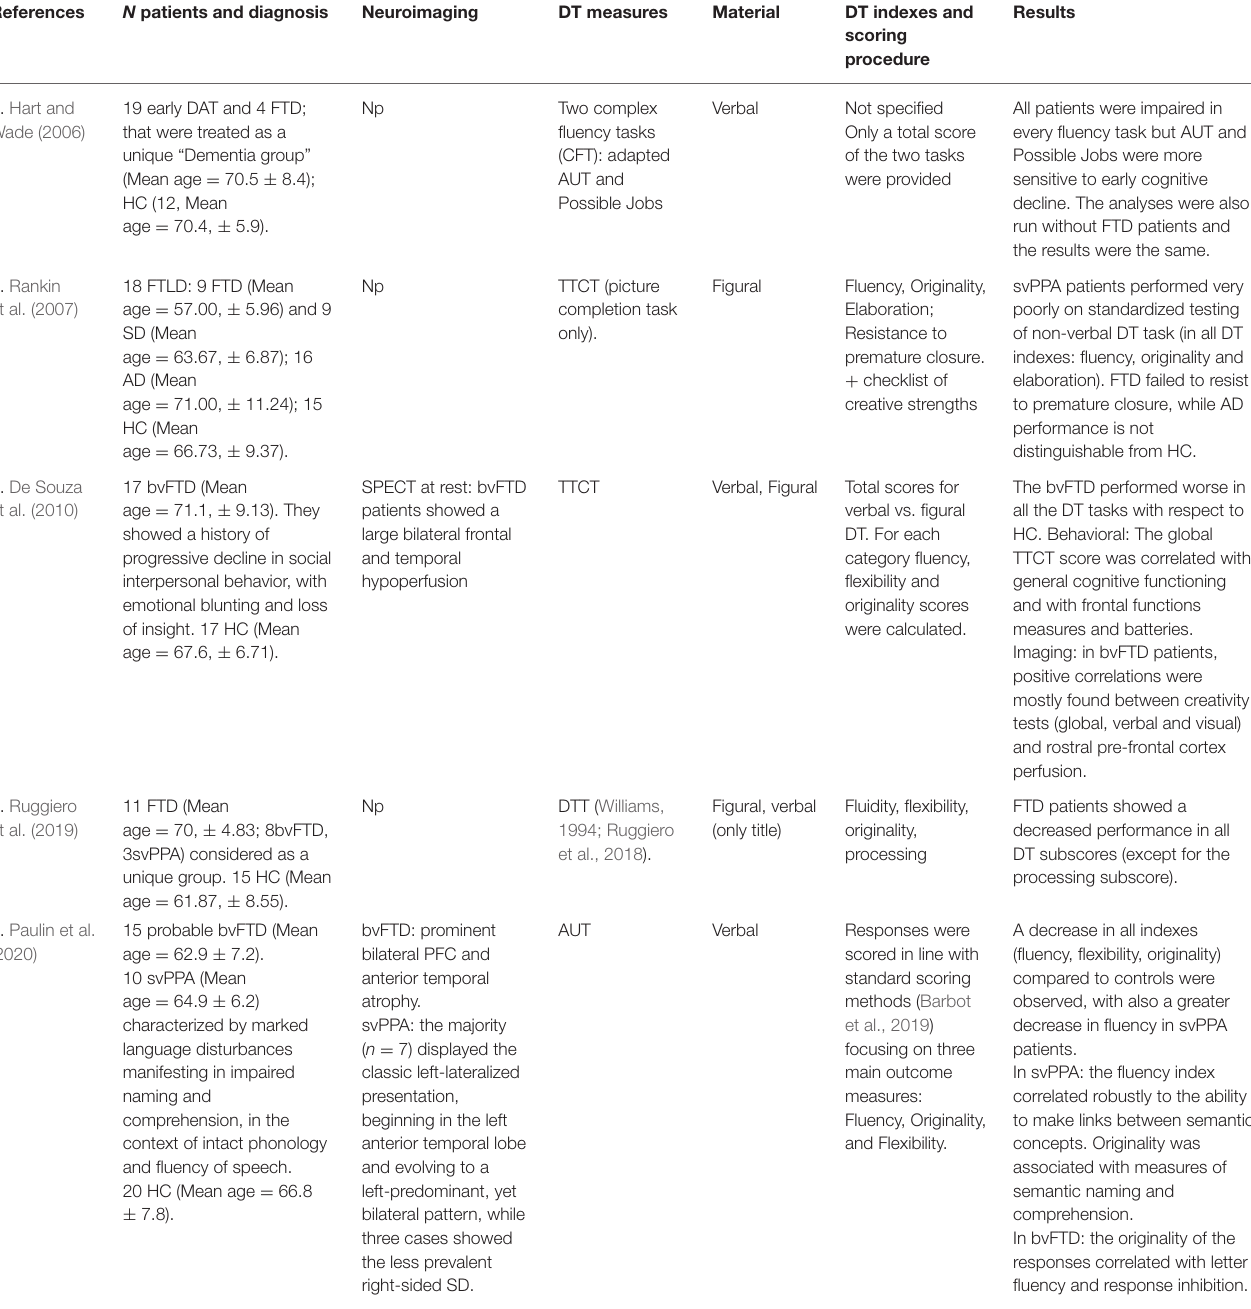
TABLE 2 | Studies exploring DT abilities in FTD patients: characteristics, provided data, and results.